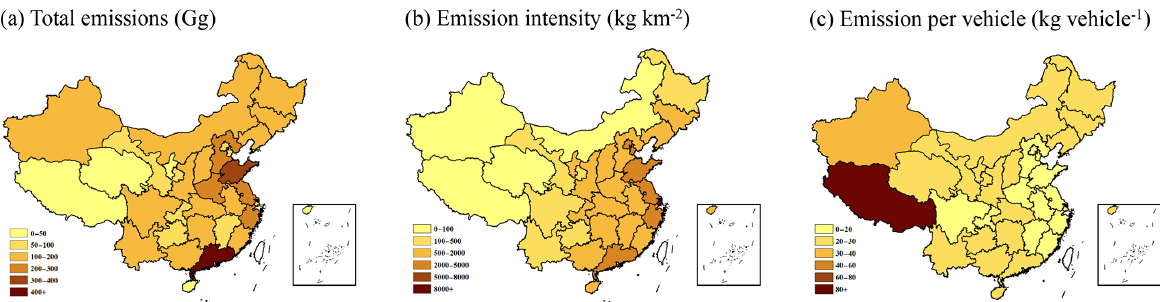
Figure 7. Province-based emission analysis: (a) total emission amount; (b) emission intensity; (c) emission per vehicle (motorcycles were excluded).